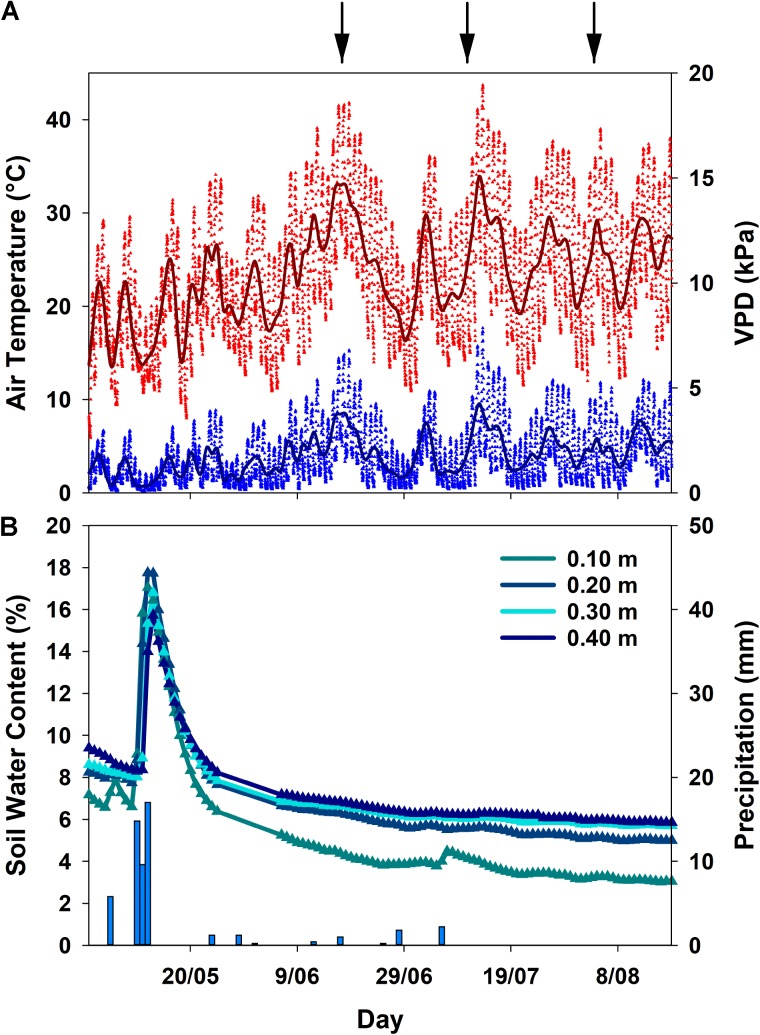
Smoothing mean for air temperature and vapor pressure deficit (VPD) (A), mean daily soil water content (n = 4 per depth) and total precipitation (B) in Vila Viçosa during the sampling period. Symbols indicate values measured half-hourly. Due to sensor failure, the period between 25 May and 6 June represents an overall trend in soil water content, but not actually measured values. Arrows indicate the sampling campaigns.